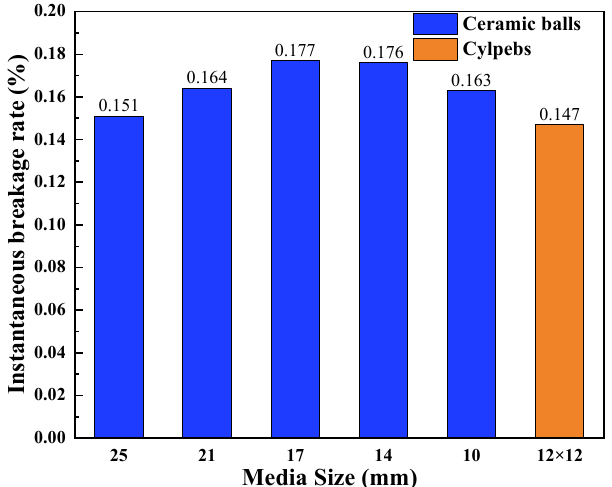
Figure 6. Instantaneous breakage rates of the ground products at the same total mass. Compared with 12 × 12 mm cylpebs, 17 mm ceramic balls have the same single mass, total number of grinding media, and total mass, but a larger total surface area. As illustrated in Figure 7, the instantaneous breakage rate (0.177 min − 1 ) of 17 mm ceramic balls is larger than that (0.147 min − 1 ) of 12 × 12 mm cylpebs. This may reflect the fact that ceramic balls have a larger total surface area than cylpebs, which is beneficial to fine grinding with the same total charge mass and same total number of charges.